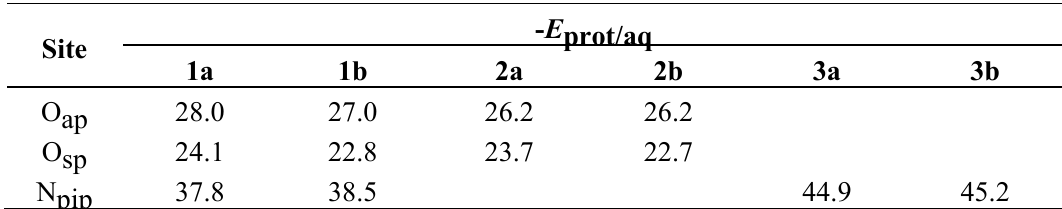
Table 5. Energies of protonation ( E prot/aq) a calculated for heteroatoms in cytisine ( 1 ) and its model compounds: N -methyl-2-pyridone ( 2 ) and piperidine ( 3 ) in